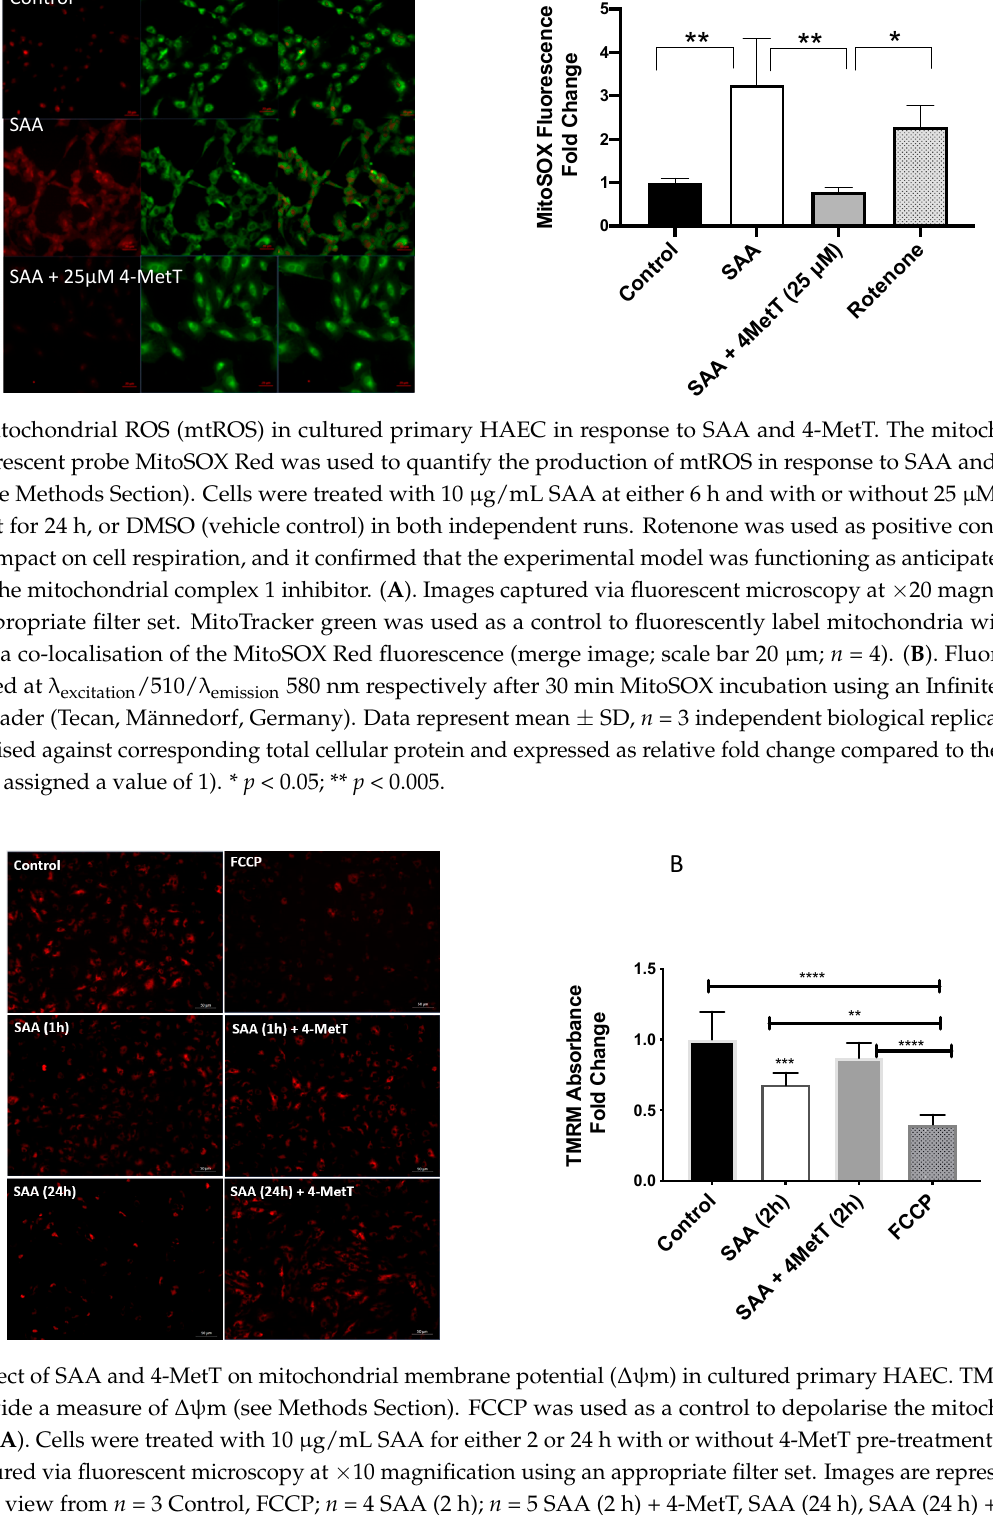
. MitoSOX Red . . MitoTracker Green . . Merge .